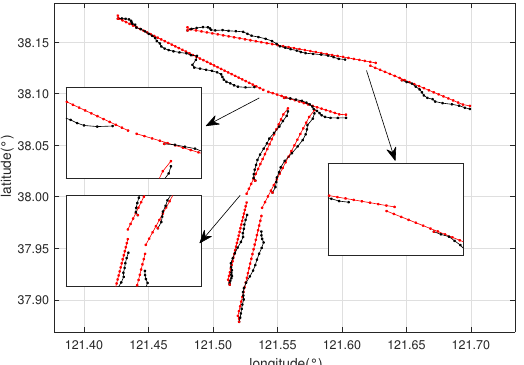
Figure 9. Bidirectional prediction results.